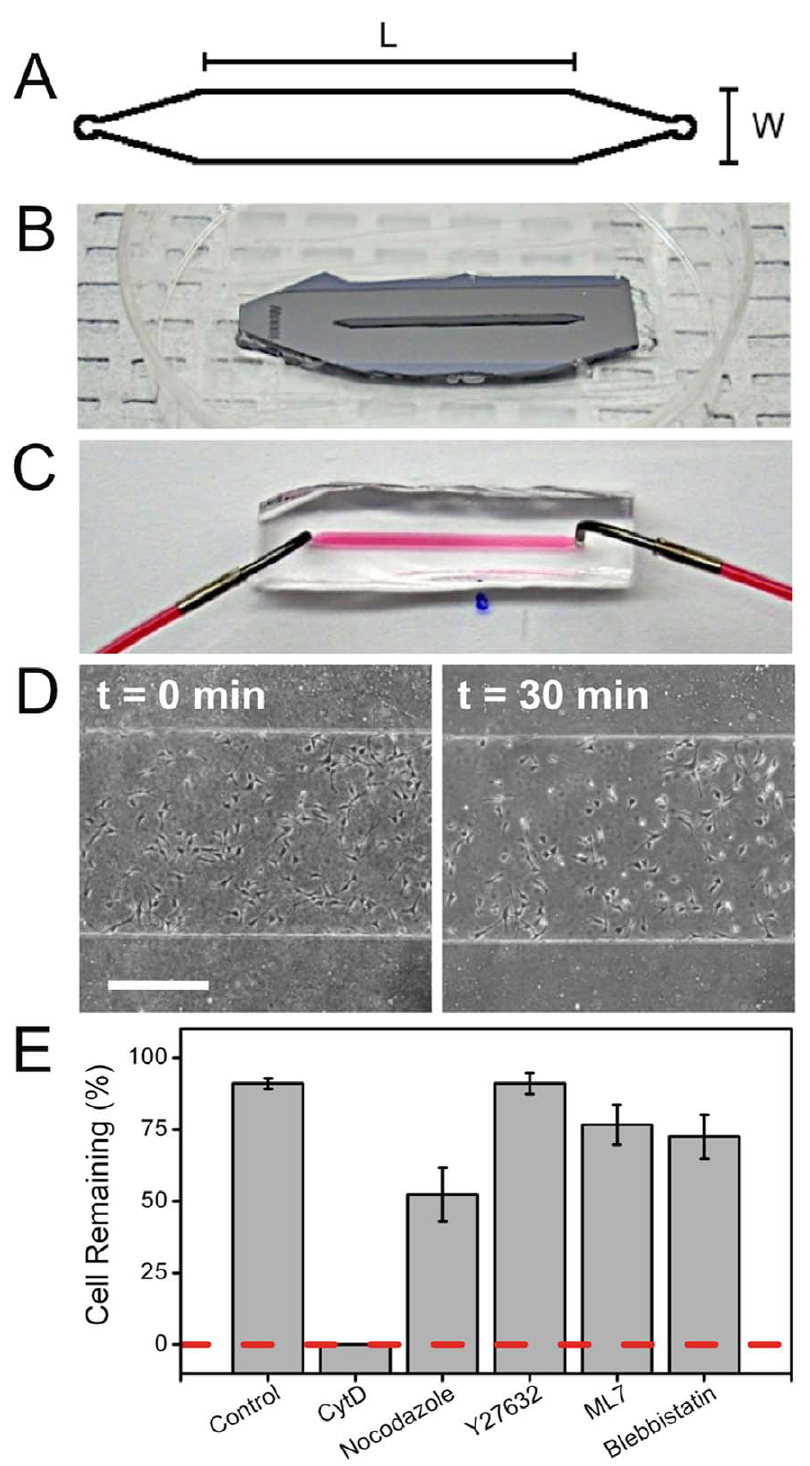
Figure 5. Flow chamber adhesion assay and changes in cell adhesion strength. ( A ) In face flow chamber dimensions: L=2 cm and W=1 mm. ( B ) SU-8 master used to fabricate flow chamber with a height of 160 m m. ( C ) Water with red dye shows the flow chamber working principle with bent stainless steel needle attached to the inlets and outlets allowing media to be pumped through the chamber. ( D ) Typical adhesion assay where cells were exposed to shear stress over a period of 30 min. Cells were counted before and after flow to quantify changes in cell-substrate adhesion strength (scale bar=500 m m). ( E ) Bar graph showing the ratio of cells remaining on the glass substrate after exposition to a shear stress of 65 Dyne/cm 2 over a period of 30 min. There is no significant difference between the control and Y27632 treatment (p . 0.1). All other treatments yield a significant decrease relative to the control (p , 0.04).